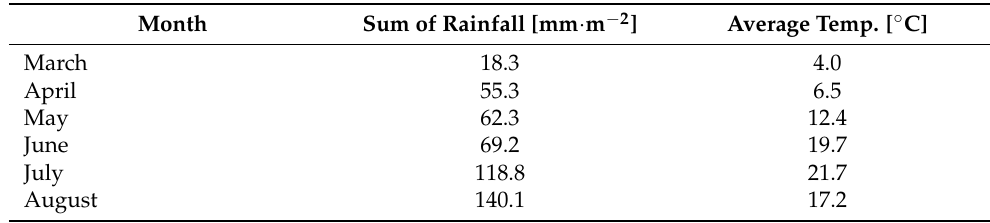
Table 1. Meteorological conditions during 2021 vegetation